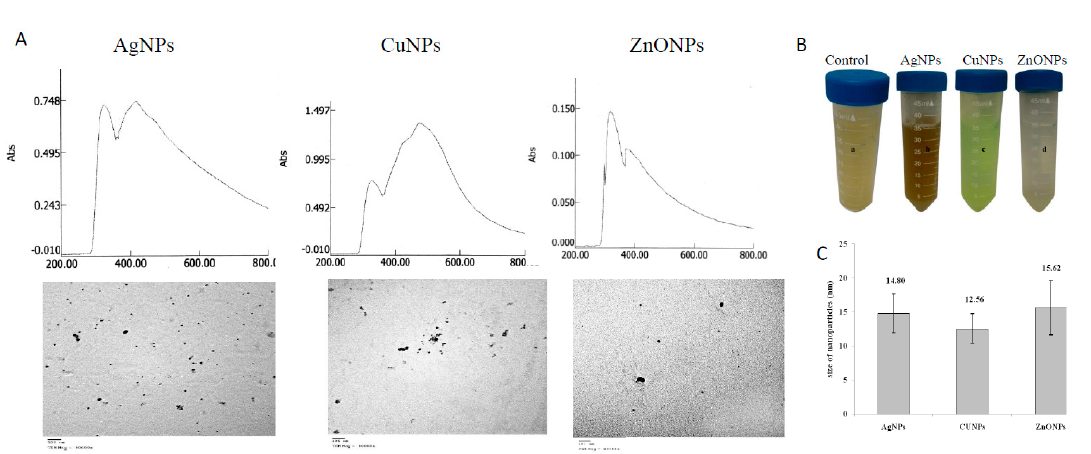
Figure 1. Phytosynthesis of silver nanoparticles (AgNPs), copper nanoparticles (CuNPs), and zinc oxide nanoparticles (ZnONPs) by aqueous extract of Zingiber officinale . ( A ), UV-Vis analyses (upper panel) and TEM images (lower panel) of the synthesized NPs. ( B ) The visual appearance of NPs. ( C ), Average sizes of synthesized NPs.